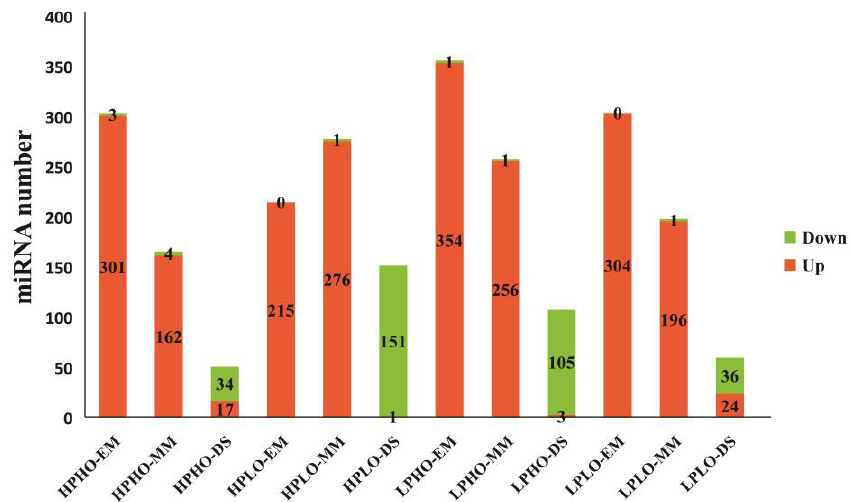
Figure 3. The number of di ff erentially expressed up-regulated miRNAs and down-regulated miRNAs in four lines (HPLO, LPHO, HPHO, LPLO) compared with the control at three stages (EM, MM, DS). Up-regulated miRNAs are represented in orange and down-regulated miRNAs are represented in green.